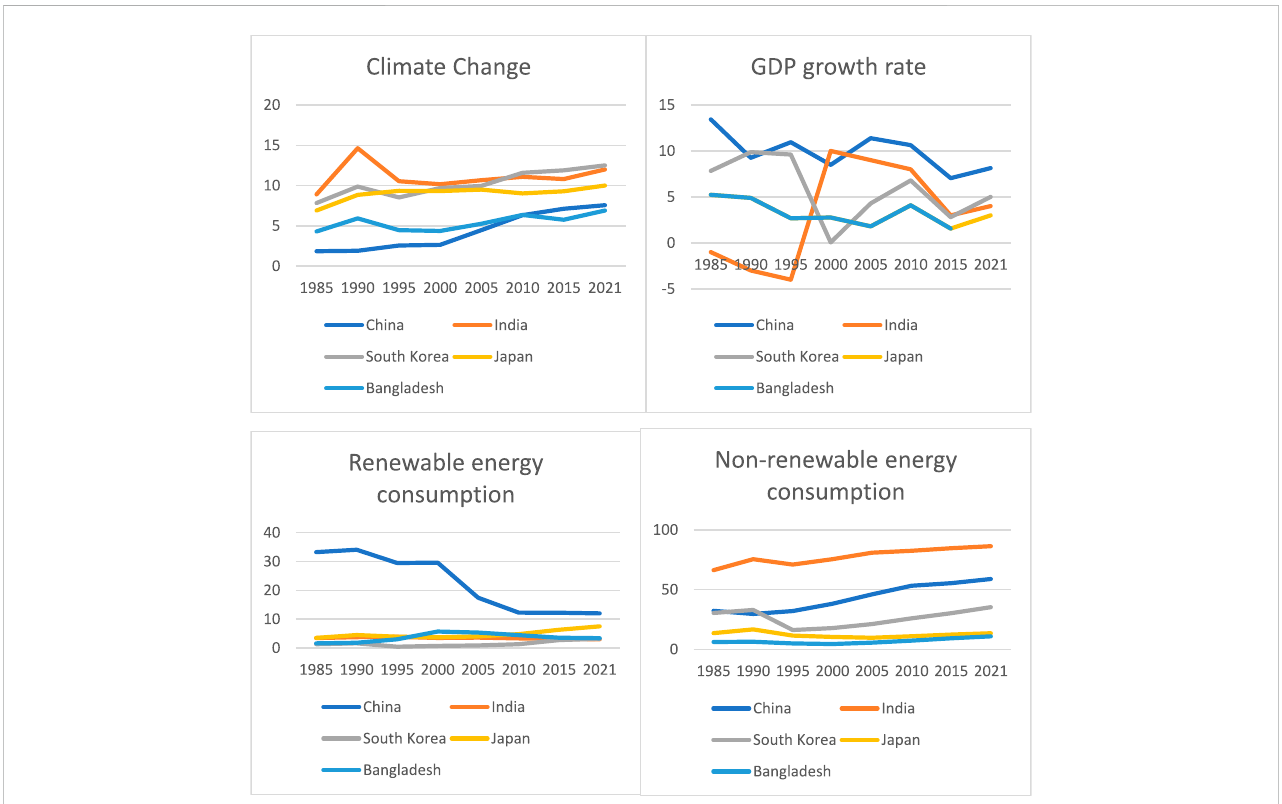
FIGURE 1 Renewable and non-renewable energy consumption, economic growth and carbon emission in Emerging Asian countries. Note: Renewable and non- renewable energy consumption are shown as a percentage of total energy, GDP growth rate is displayed as an annual percentage, and climate change as annual average